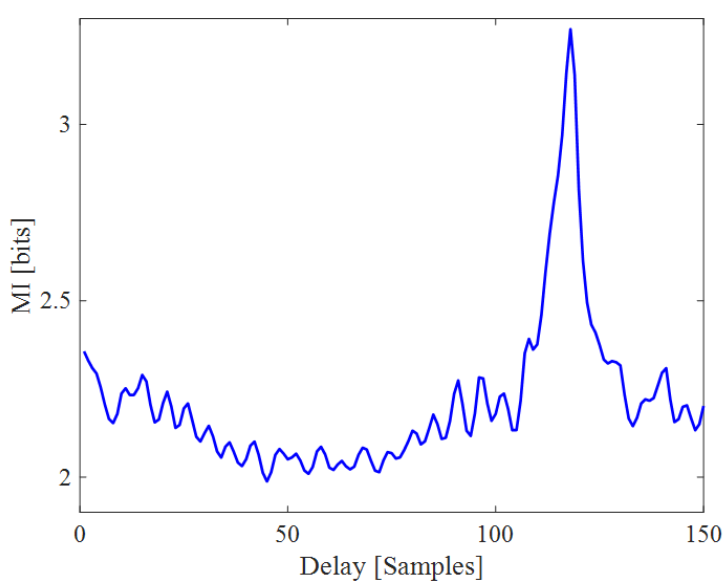
Figure 4. Example of the pattern extracted using the SMI signal processing technique between the current signals of phases A and B—Motor 1 operating without faults, with nominal load torque, and balanced supply